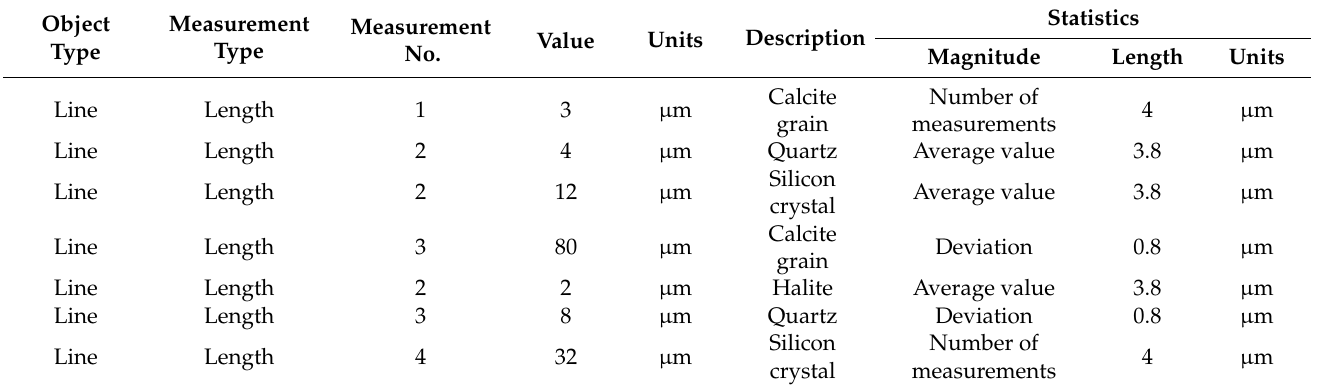
Table 3. The dimensions of the primary components of the S1 sample series.